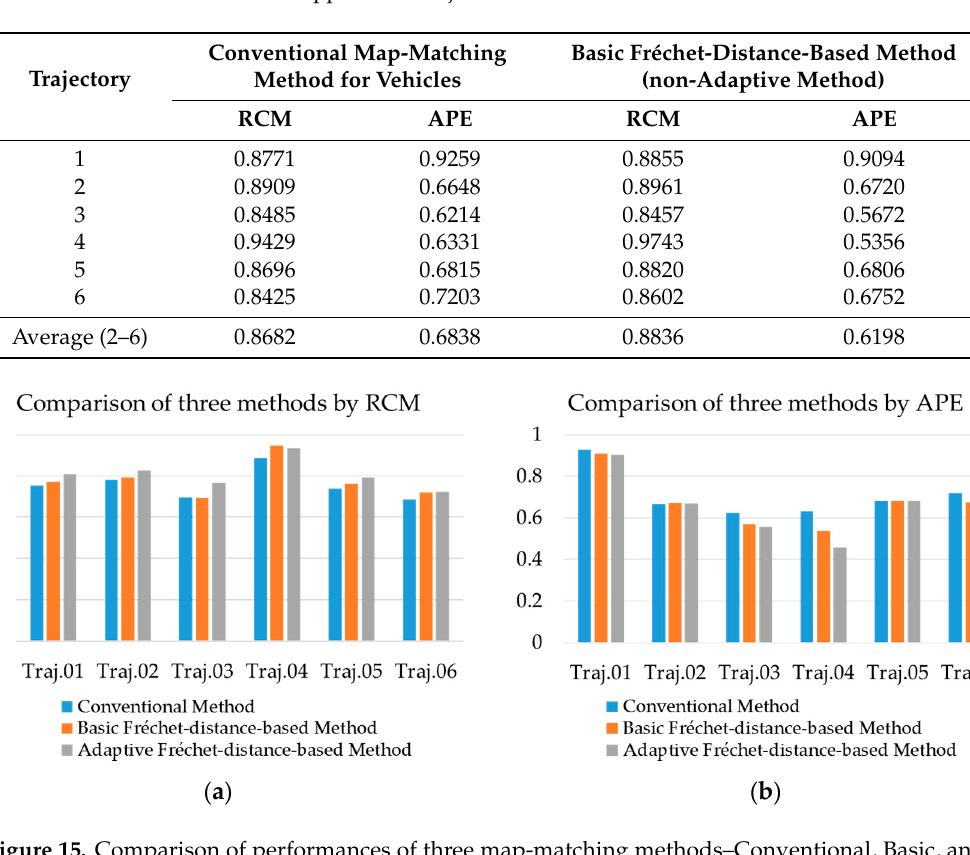
Figure 14. Some parts of the map-matching results obtained by the adaptive Fréchet-distance-based method. Thick lines are PND segments and circles are GPS-recorded points. Lines connecting points and PND segments are the matching relations from the results. Table 6. Performance indices from map-matching by the conventional method and the basic Fréchet-distance-based method applied for Trajectories 1–6.